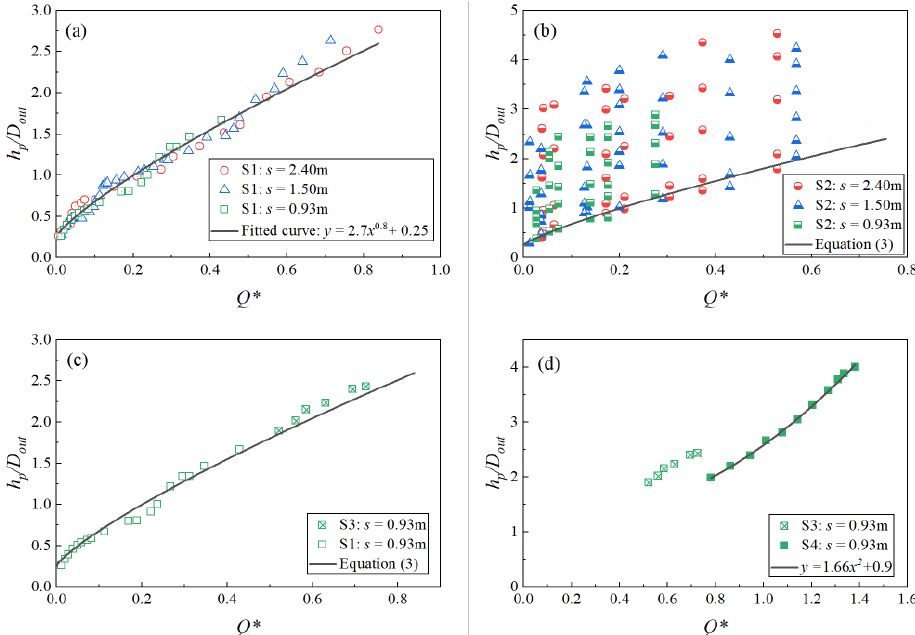
Figure 4. Dimensionless water level versus drop parameter at: ( a )stage S1; ( b ) stage S2 ; ( c ) stage from S1 to S3; ( d ) stage S3 and